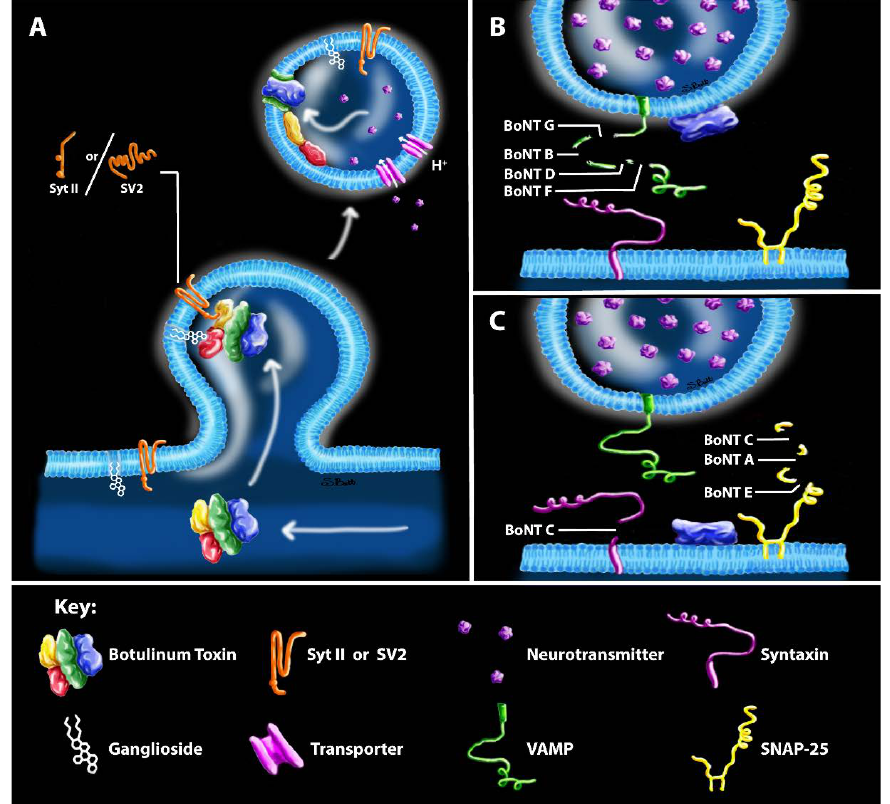
Figure 2. Classical model of toxin uptake and catalytic engagement with SNARE proteins. ( A ) Toxin uptake occurs through binding of a protein and lipid co-receptors and internalization via synaptic endocytosis. ( B ) Summary of LCs that cleave VAMP. ( C ) Summary of LCs that cleave SNAP-25. Structures correspond to the key at the bottom of the